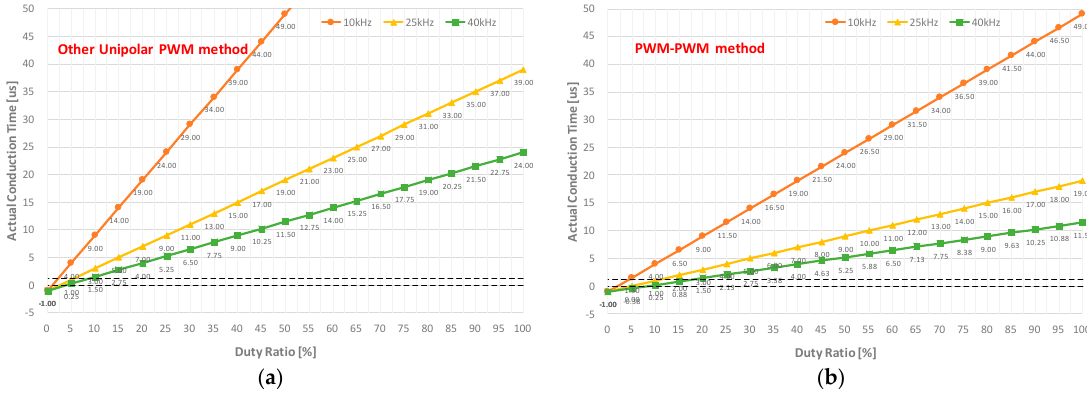
Figure 6. Sensing range of DC-link current on the basis of PWM method and switching frequency: ( a ) Other unipolar PWM methods; and ( b ) H-PWM-L-PWM method.